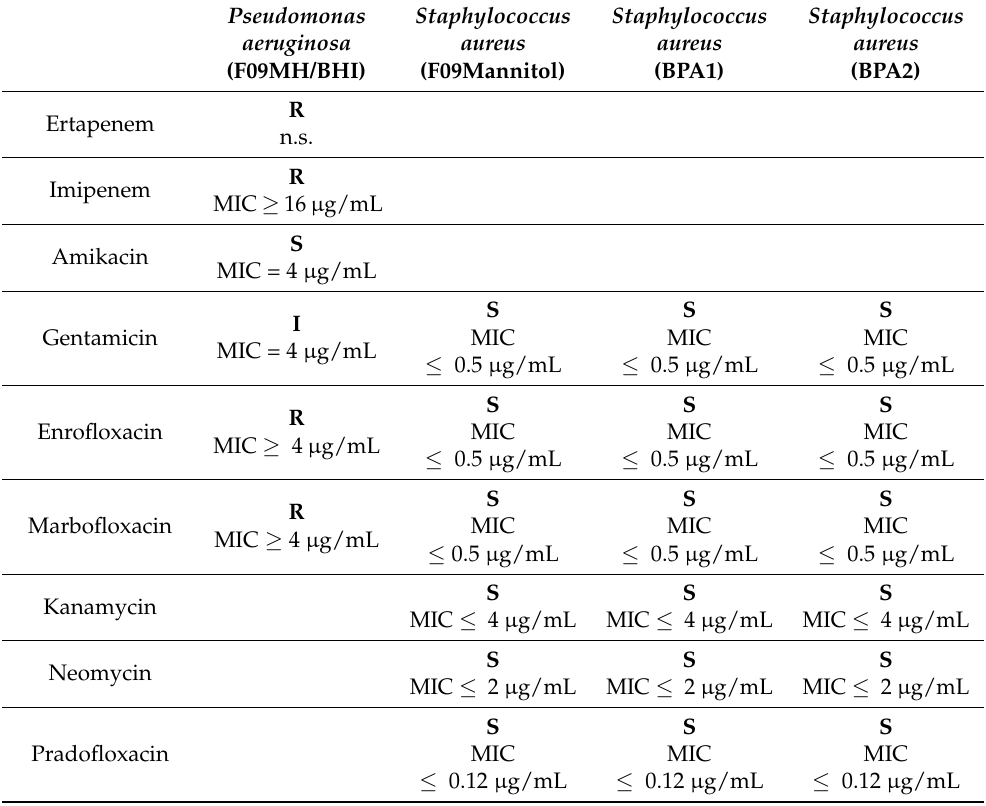
Table 1. Bacterial identification and antibiotic susceptibility profile using the VITEK ® 2 automatic system. Antibiotic susceptibility results were tested and read according to the recommendations of the Clinical and Laboratory Standards Institute (CLSI), and are expressed as sensitive (S), intermediate (I), or resistant